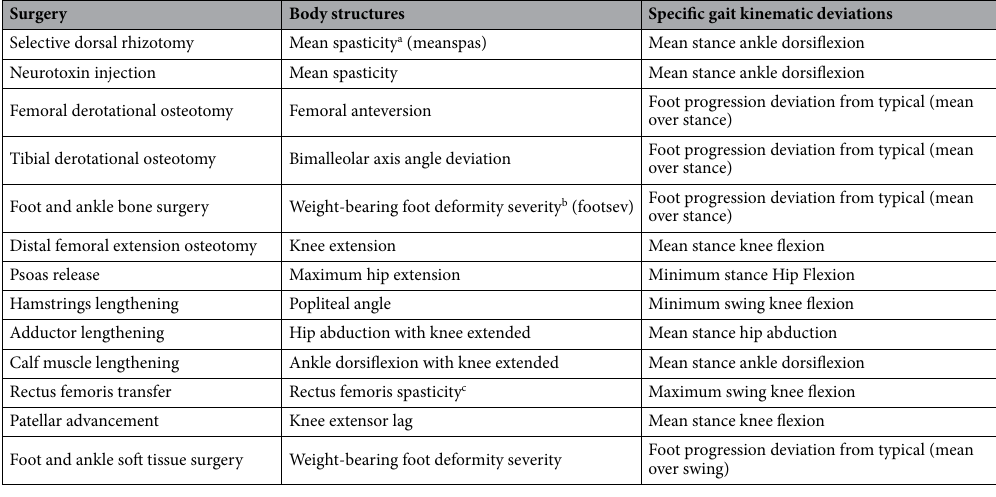
Table 8. Treatments and Outcome measures. a Mean Spasticity (meanspas) = Ashworth score averaged over adductors, hamstrings, rectus femoris, plantarflexors. b Foot deformity severity (footsev) = numerical severity score (0-typical–3-severe) averaged over weight-bearing hindfoot and forefoot severity assessment. c As measured by physical